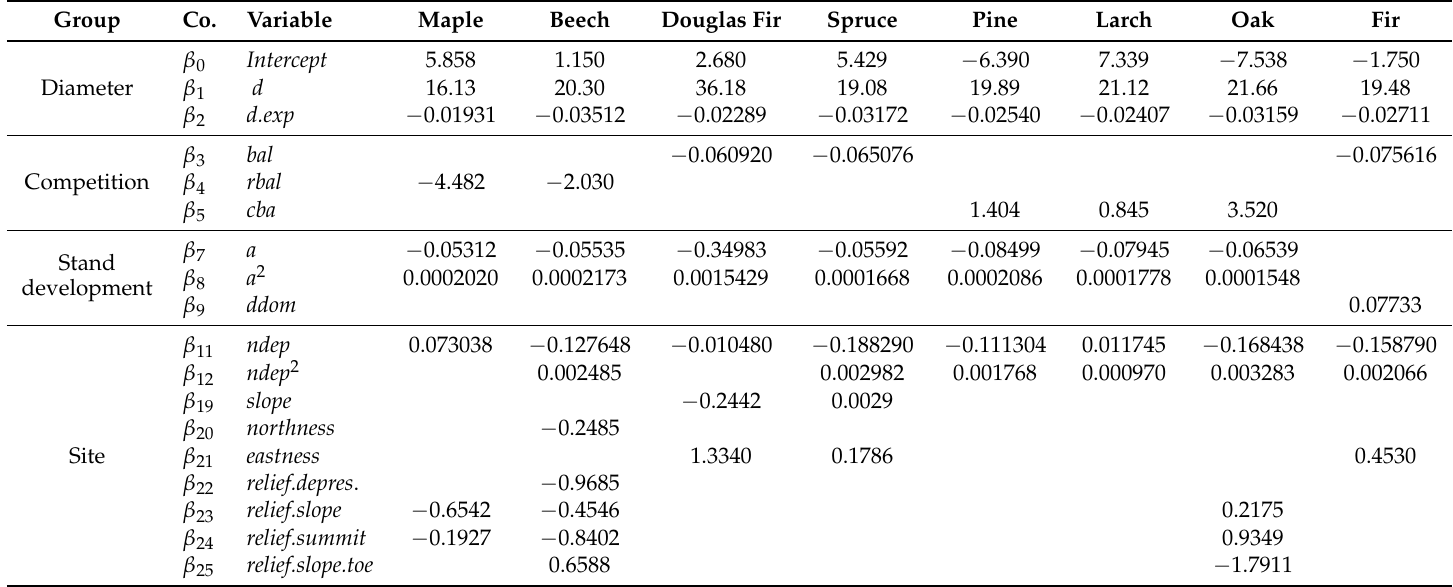
Table 2. Selected models and estimated coefficients (“Co.”). A blank space means that the variable was not part of the final model. The standard errors of the coefficients can be found in the Supplement